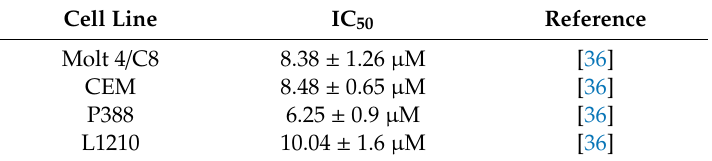
Table 3. Inhibitory effect of compound 2 against human Molt 4/C8, CEM T-lymphocytes, murine P388, and L1210.